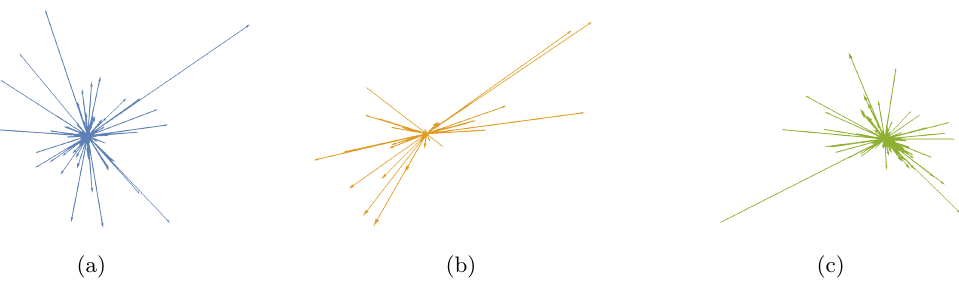
Figure 13 . Visualizations of a characteristic final state radiation pattern for the (a) bulk coupling, (b) boundary coupling, (c) mixed ( ˜ c = 0 . 015 c ) samples. In each case, ν = 0 . 3 and we assume Neumann boundary conditions. Each event has event isotropy equal to the mean value for the corresponding event sample: (a) hI sph i = 0 . 33 ; (b) hI sph i = 0 . 67 ; and (c) hI sph i = 0 . 55 . The plots 192 192 192 show that events with boundary couplings are visibly less isotropic than the sample with only a bulk coupling.